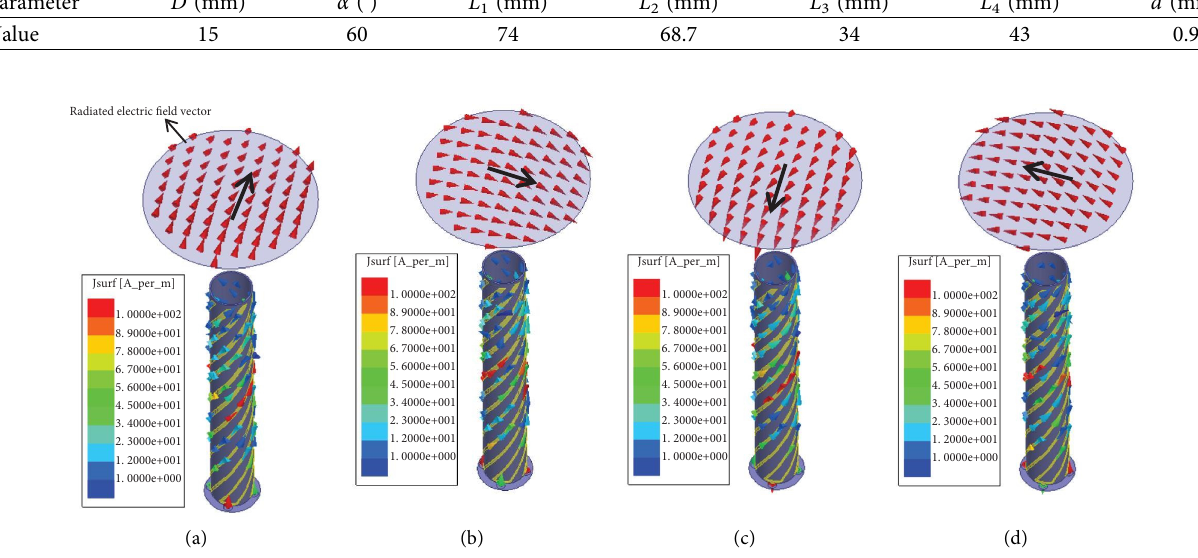
Figure 2: Surface current and radiated electric feld distributions of QHA at 1.995GHz: (a) 0 ° , (b) 90 ° , (c) 180 ° , and (d) 270 °